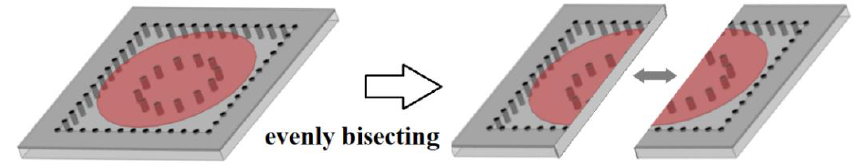
Figure 4. Evenly bisecting the full-mode SICR cavity to make the HMSICRs.